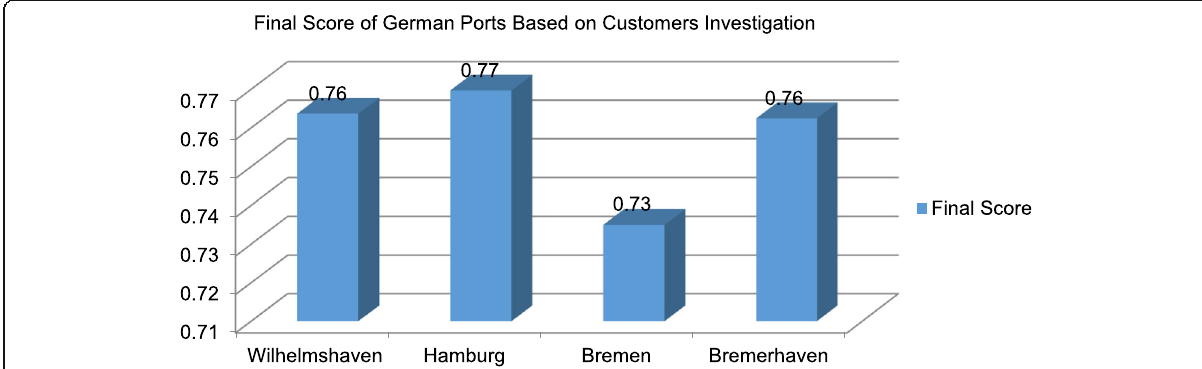
Fig. 5 Final score of german ports based on customers investigation. (Source: